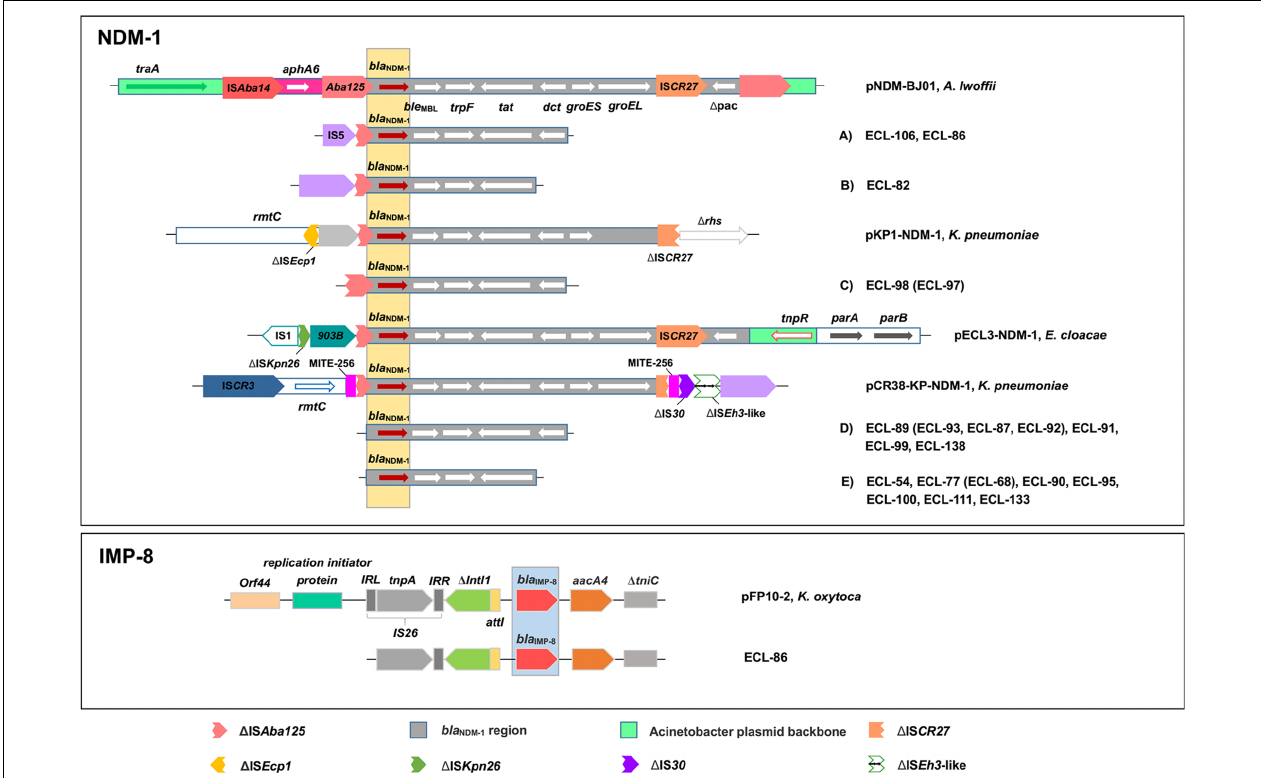
FIGURE 2 | Comparison of the genetic elements surrounding the bla NDM − 1 and bla IMP − 8 genes identified in this study. Reference sequences: A. lwoffii (pNDM-BJ01, GenBank accession no. JQ001791), K. pneumoniae (pKP1-NDM-1, GenBank accession no. KF992018 and pCR38-KP-NDM-1, GenBank accession no. KP826710), and E. cloacae (pECL3-NDM-1, GenBank accession no.